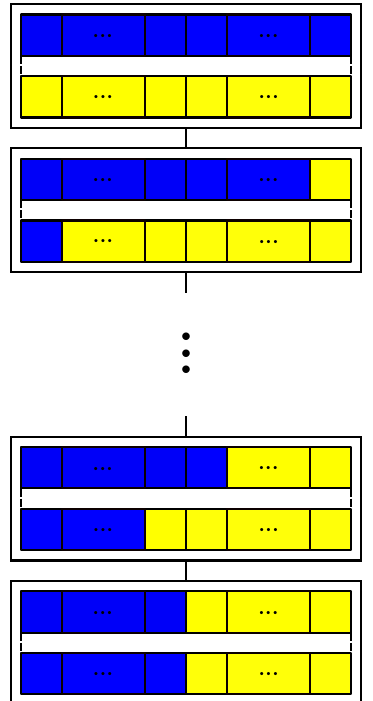
Figure 13. The tree of (cid:13)avor-equivalence classes for Sp( N ) + N a AS , SO( N ) + N V V , G 2 + N 7 7 , and F 4 + N 26 26 . What is shown are the decorations/colorings of the undecorated part in (cid:12)gure 12. All of these theories have a symplectic group acting as rotations on the hypermultiplets, this is the key feature that controls the (cid:13)avor-equivalence classes, and thus each of these theories has the same structure for their (cid:13)avor-equivalence